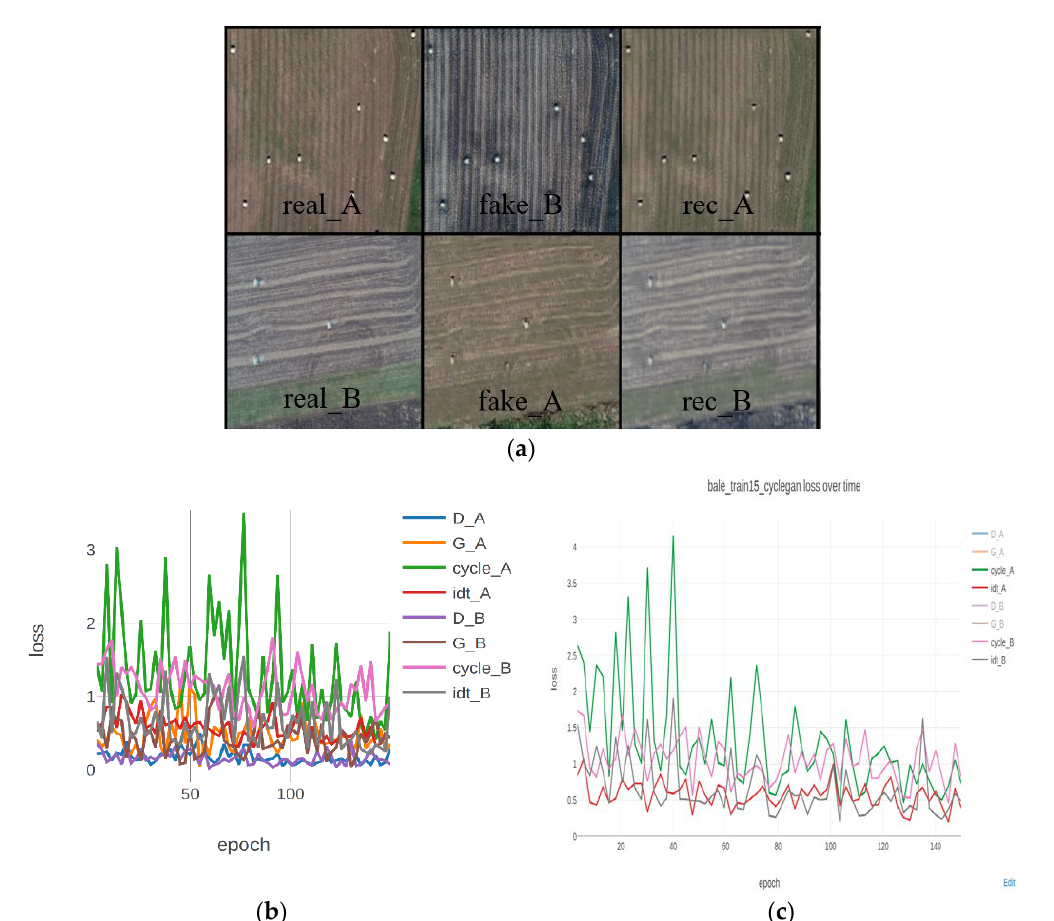
Figure 9. Description of the CycleGAN model: ( a ) examples of the real images, fake images, and reconstructed images; ( b , c ) loss tracking during training of the CycleGAN model, during repeated training.